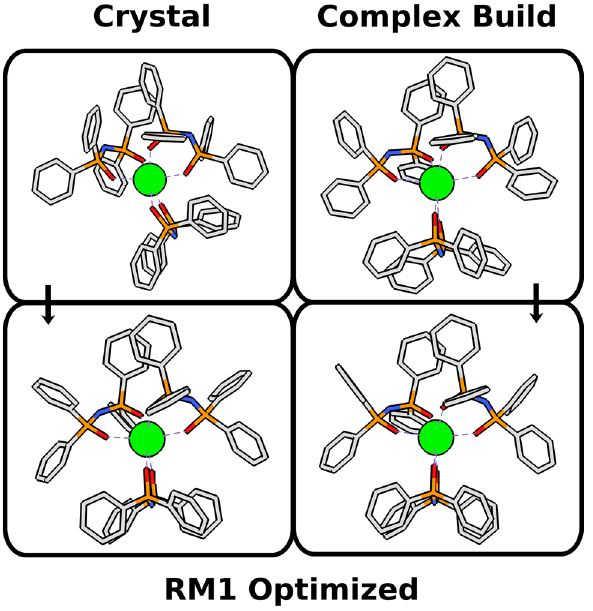
Figure 9. Pr(III) complex tris(tetraphenylimidodiphosphinato)-praseodymium of stereoisomer ID 16 {[M(AA)3] OC-6 D3 c 6 A [1 2 5 4 3 6]} found in CSD by entry ZAXRUL. On the top left, the crystallographic structure from the Cambridge Crystallographic Data Center, and, on the bottom left, the structure obtained after its RM1 optimization. On the top right, we show the structure composed by the Complex Build algorithm at the same stereoisomer configuration as that of its corresponding crystallographic one; and, on the bottom right, similarly, the structure obtained after its optimization using the RM1 Hamiltonian.